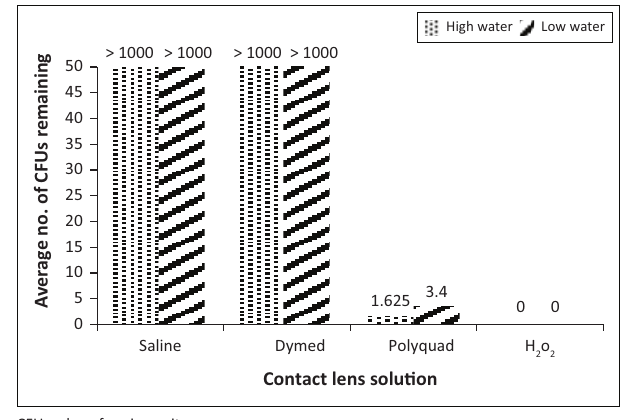
FIGURE 3: Solution effectiveness on high water content versus low water content soft contact lenses in removing Pseudomonas